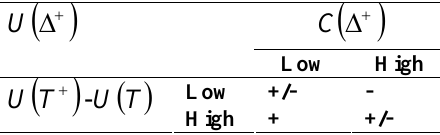
Table 2. Conceptualized determinants of the utility of choice